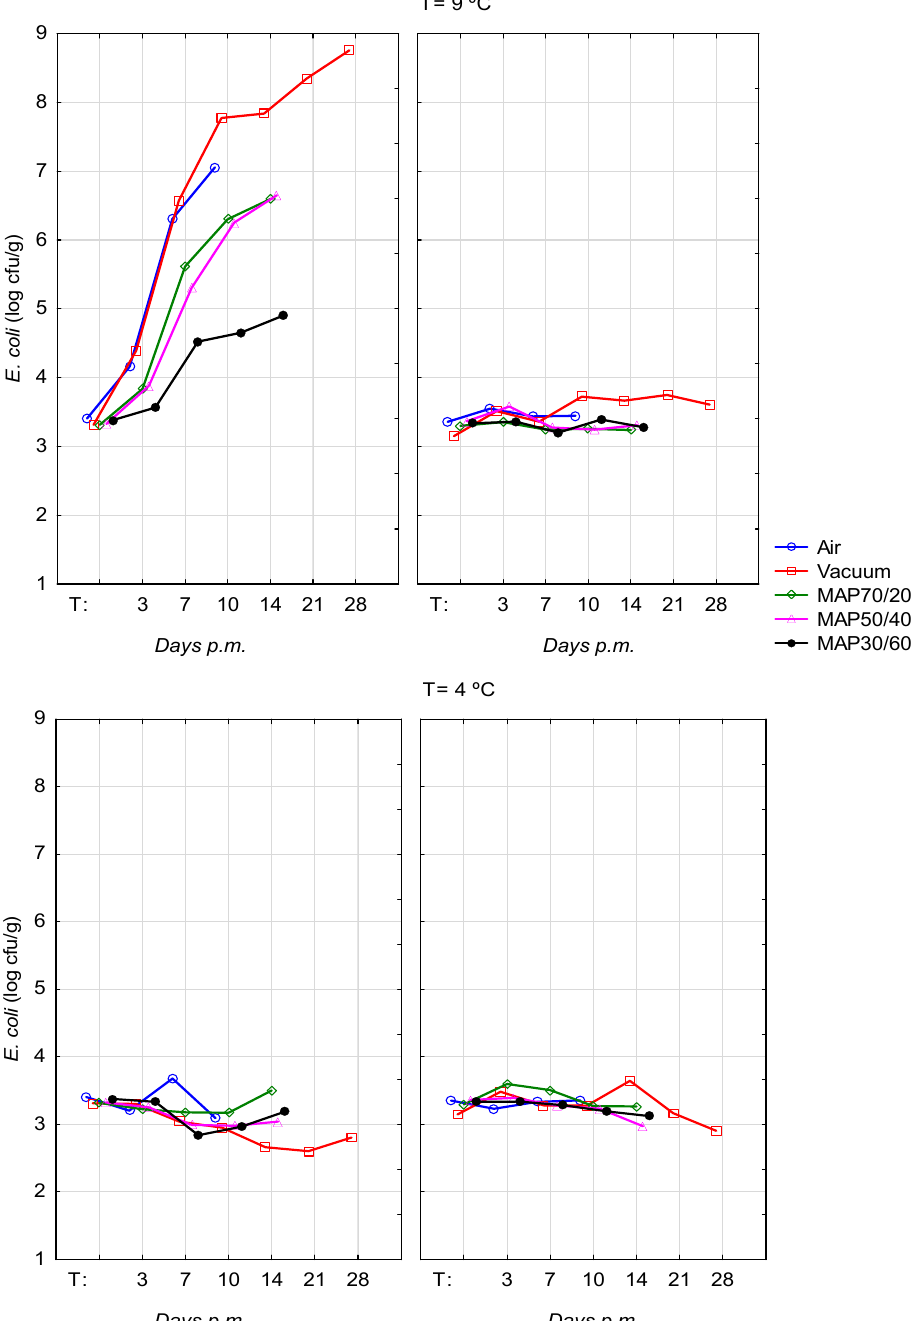
Figure 1. Evolution of E. coli O157:H7 levels (log UFC/g) on DFD (left) and Normal (right) beef stored at 4 °C and at 9 °C, packed in air, vacuum and MAPs -O 2 /CO 2 /N 2 - 70/20/10 (MAP70/20), 50/40/10 (MAP50/40), 30/60/10 (MAP30/60), during the time of storage.